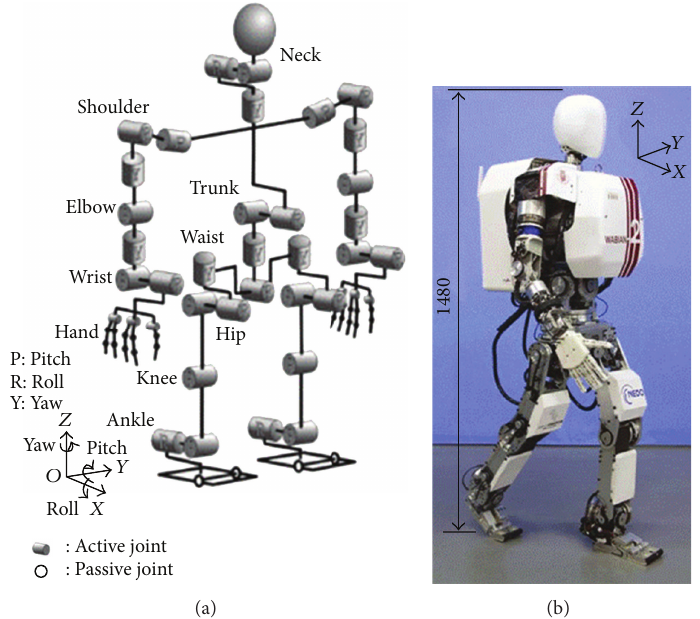
Figure 6: WABIAN-2 humanoid robot.